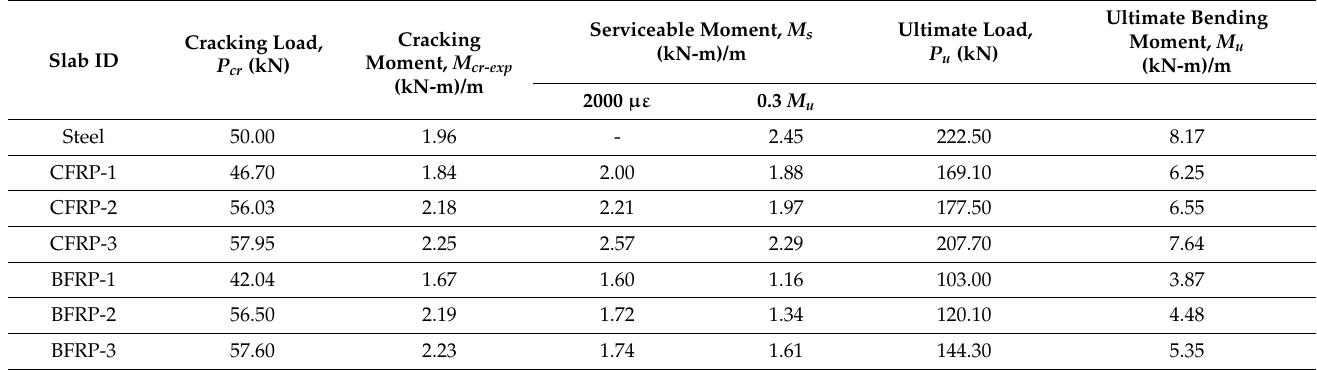
Table 4. Cracking moment, serviceable moment, and the ultimate bending moment of the concrete slabs